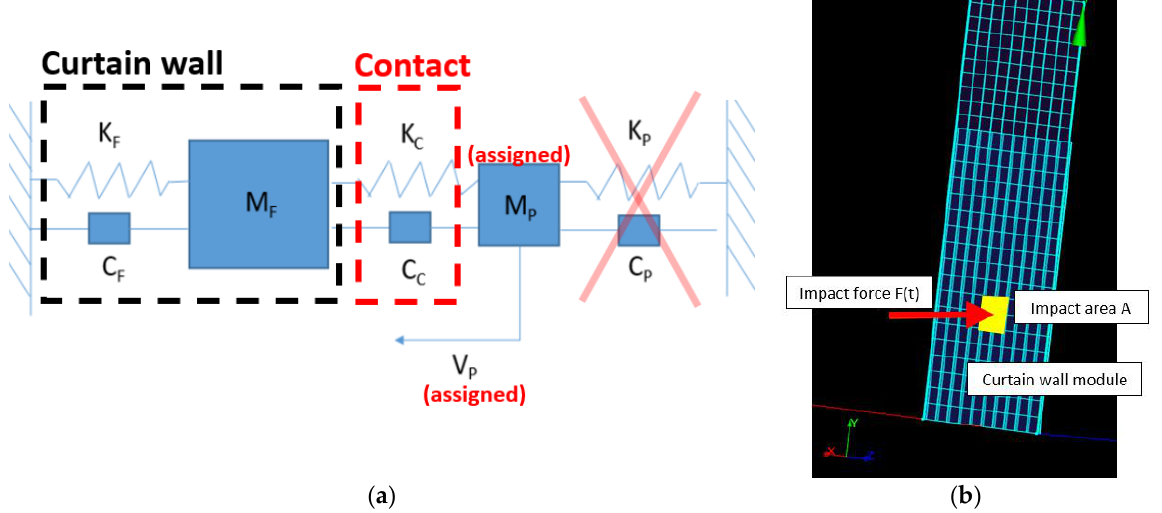
Figure 5. Reference mathematical models for the proposed coupled analysis of glass curtain wall under soft body impact (SBI): ( a ) 2-DOF and ( b ) FE numerical model (Code Aster).